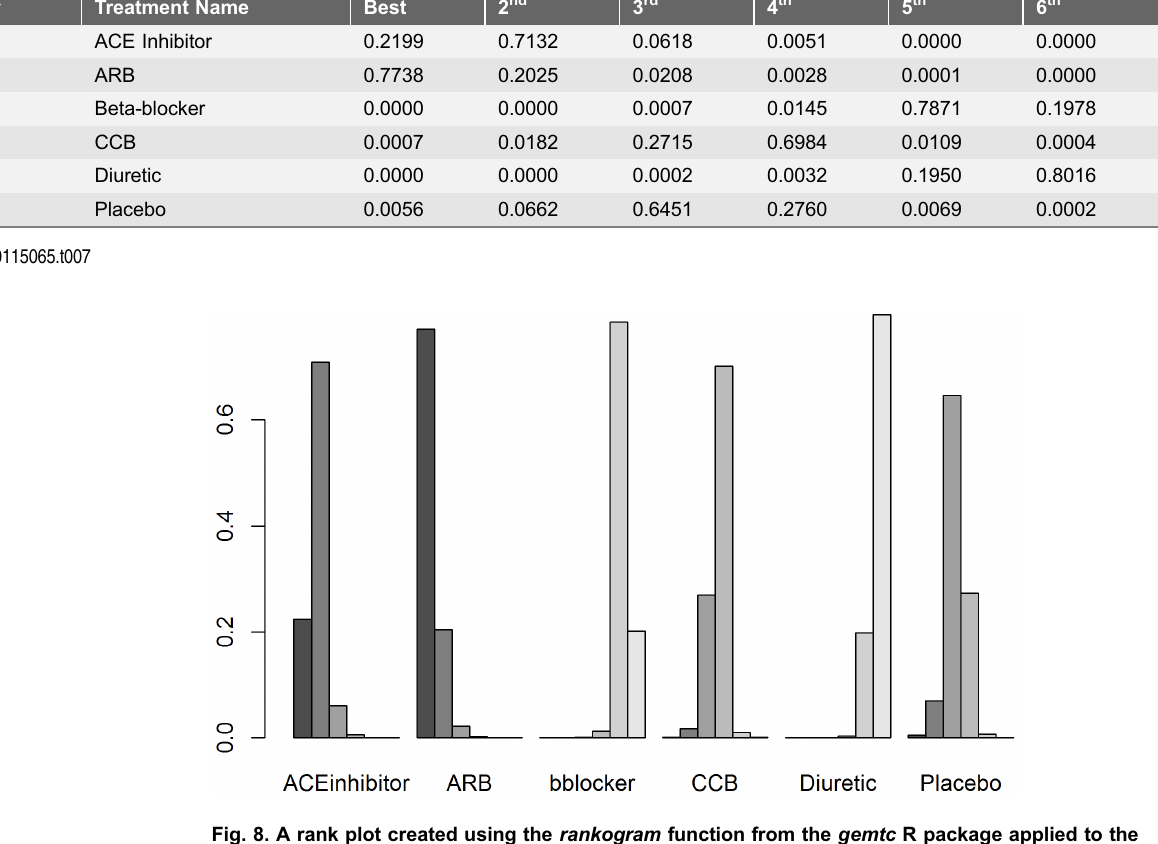
Fig. 8. A rank plot created using the rankogram function from the gemtc R package applied to the diabetes dataset illustrating empirical probabilities that each treatment is ranked 1 st through 6 th (left to right).